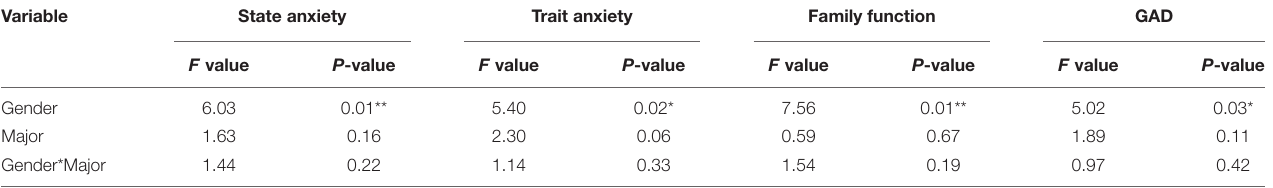
TABLE 3 | The results of Multivariate